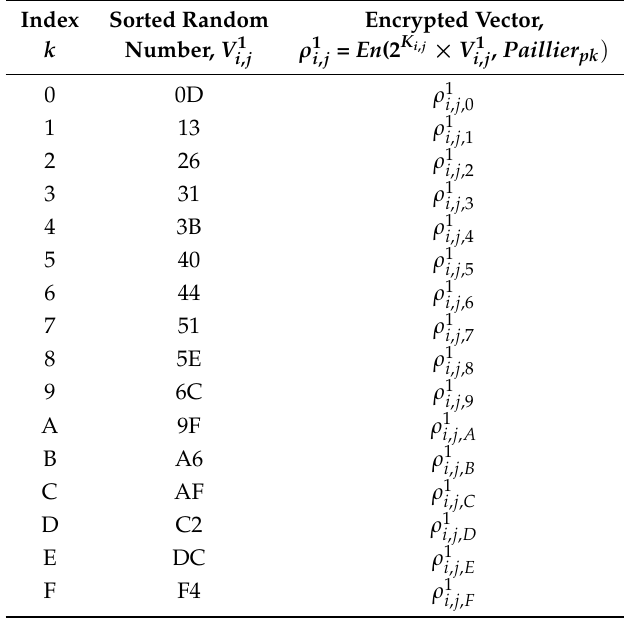
Table 6. Example of Encrypted Substitute Vector Generation for N i , j = 4 and R i , j =